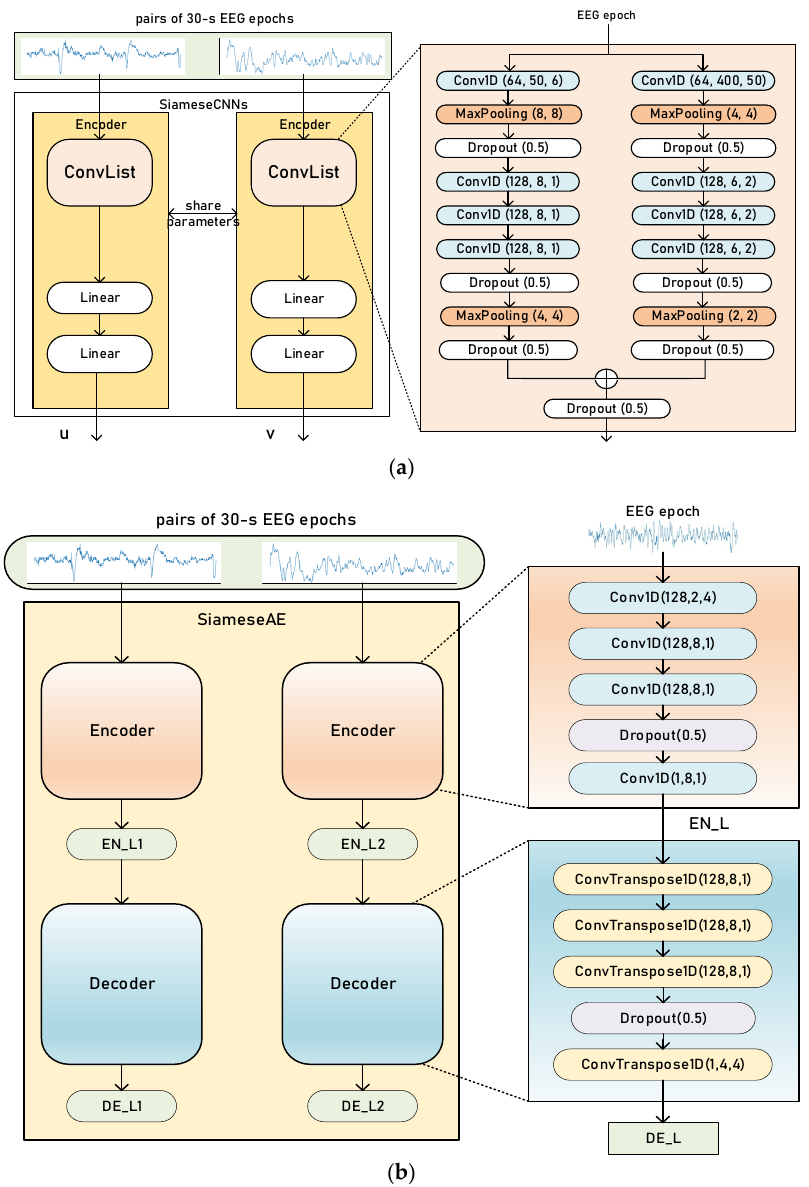
Figure 2. An overview of Siamese CNNs ( a ) and Siamese AEs ( b